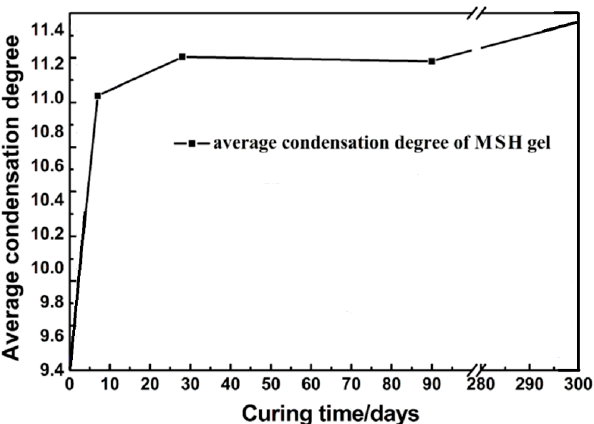
Figure 7. pH value and average condensation degree of cured MSH gel samples.